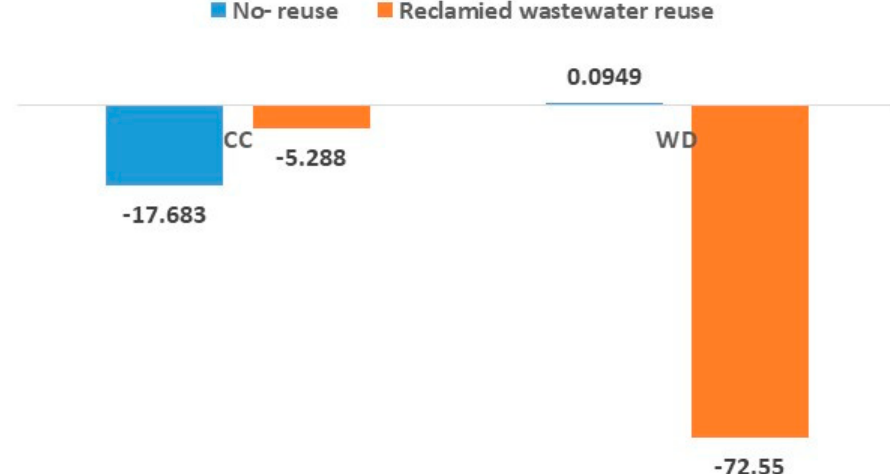
Figure 8. Water depletion (million m 3 of water) and climate change (million kg CO 2Eq ) analysis for both reclaimed wastewater reuse and no reuse scenarios (negative values mean benefits to the environment, and positive values mean damages).